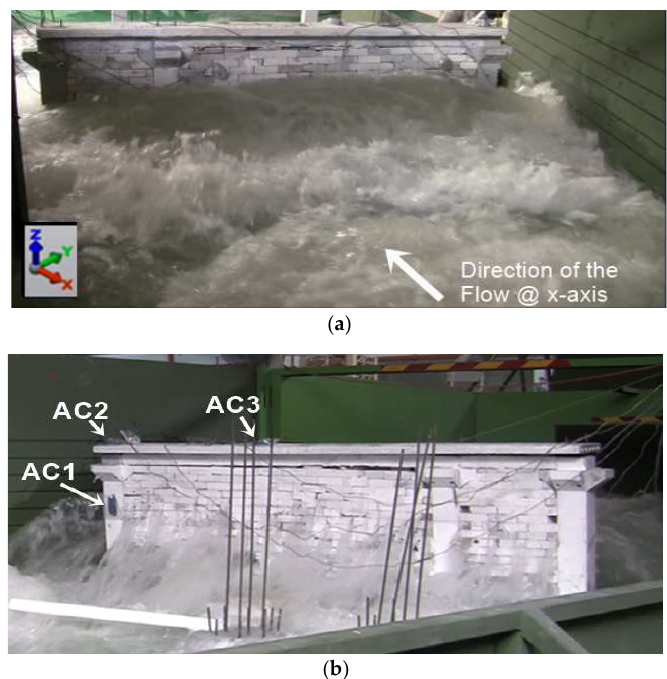
Figure 16. Dam-break test 2 for 2 m reservoir water level: ( a ) front of the frame; ( b ) back of the IBS frame.